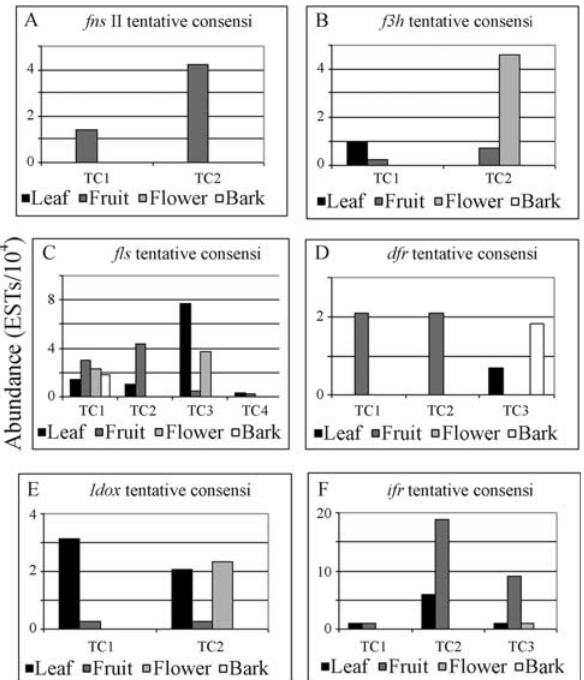
Figure 2 - Transformed data representing the relative abundance of EST reads by tissue expressed in 10 4 reads: (A) Flavone synthase II (FNS II), (B) Flavone 3-hydroxylase (F3H), (C) Flavonol synthase (FLS), (D) Dihydroflavonol 4-reductase (DFR), (E) Leucoanthocyanidin oxygenase (LDOX) and (F) Isoflavone reductase